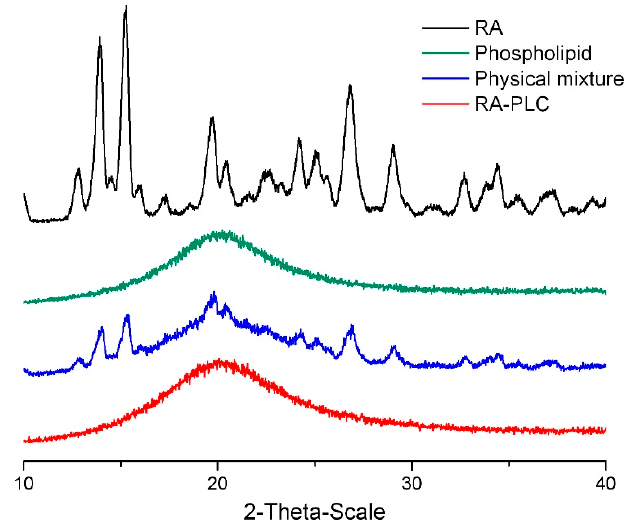
Figure 2. XRD diffractogram of rosmarinic acid (RA), phospholipid, physical mixture, and rosmarinic acid-phospholipid complex (RA-PLC).